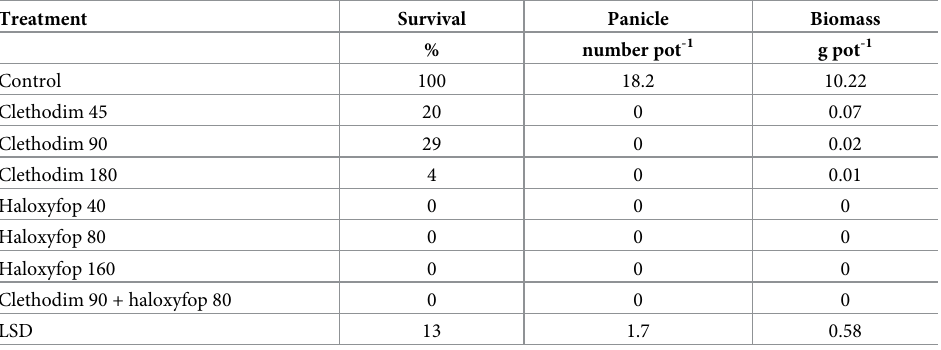
Table 4. Effect of different doses of clethodim and haloxyfop on survival, panicle production, and shoot biomass of glyphosate-resistant Chloris virgata . Herbicides were sprayed at the 24–28 leaf stage. Treatment Survival